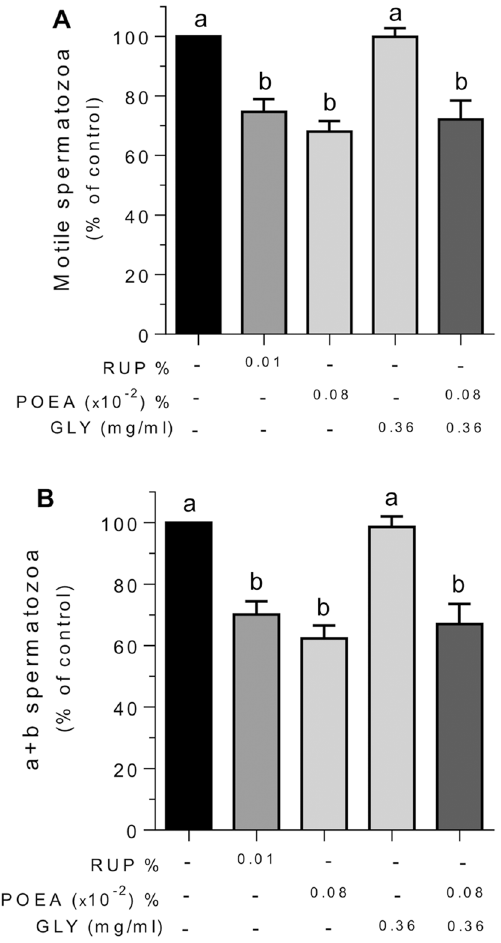
Figure 7. Effects of Roundup Ultra Plus (RUP), glyphosate (GLY) and surfactant polyoxyethylene amine (POEA) in the percentages of motile ( A ) and type a + b human spermatozoa ( B ). Human spermatozoa were incubated 1 h in BWW at 37 °C, 5% CO 2 , in the absence or the presence of indicated concentrations of RUP, GLY and POEA. Each experiment was performed 13 times (n = 13) and results were normalized and expressed as percentage of control in both cases ± standard error of the mean (SEM). Columns with different letters are statistically different from each other, so that for P <